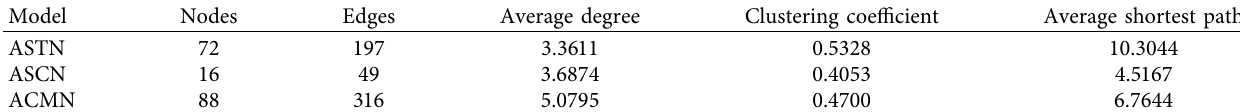
Table 1: Basic characteristics of each subnet in the ACMN.